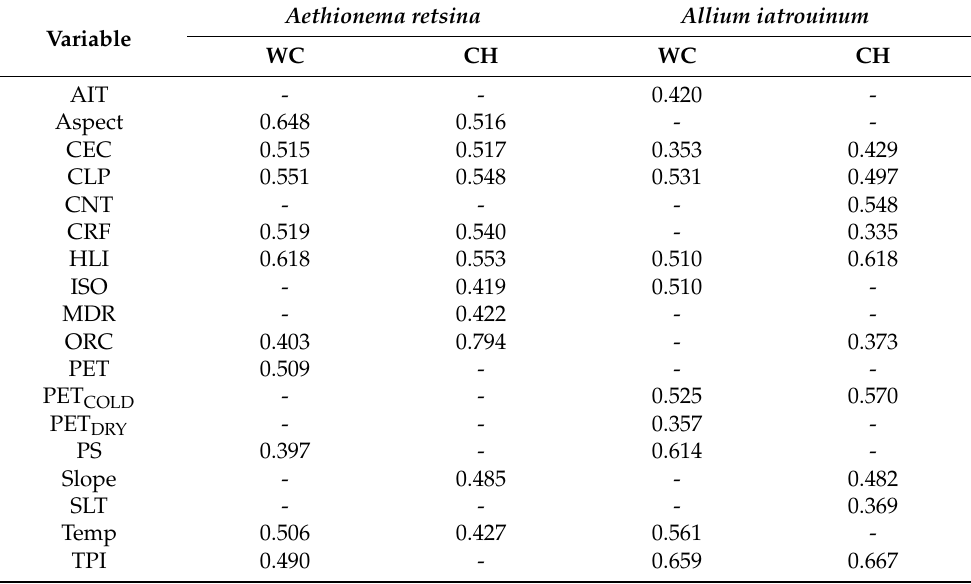
Table 4. Variable importance for the top 10 variables of models based on WorldClim (WC)